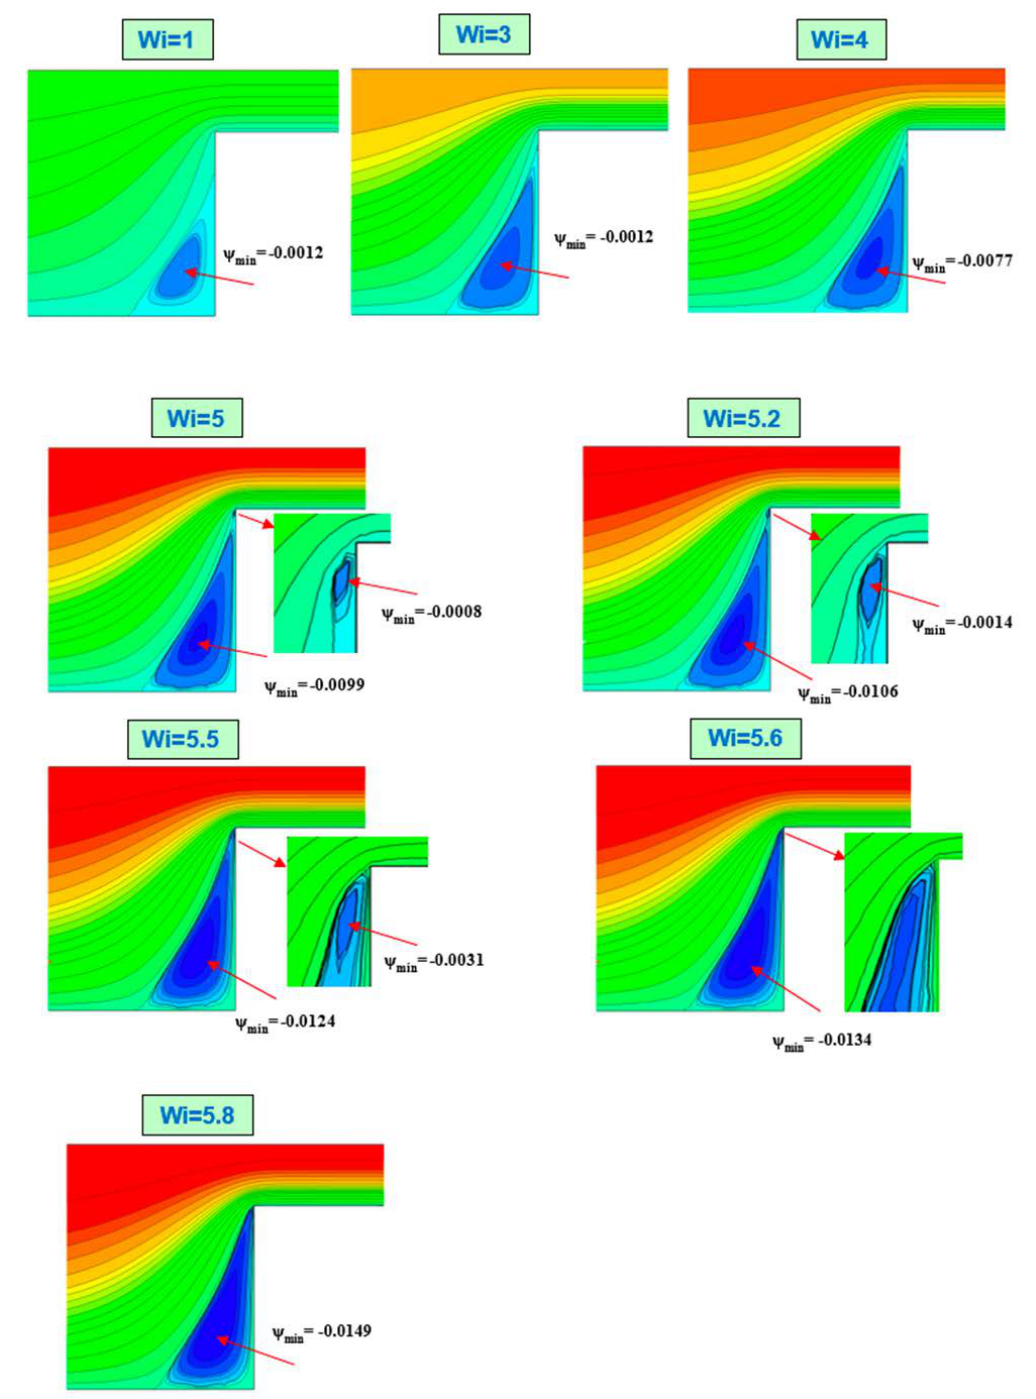
α = 4; swIM [ L = 12, β = 0.8, λ = 0.1]. − Ψ aspect λ = 0.1]. Figure 13. Vortex-intensity ( D min ); D